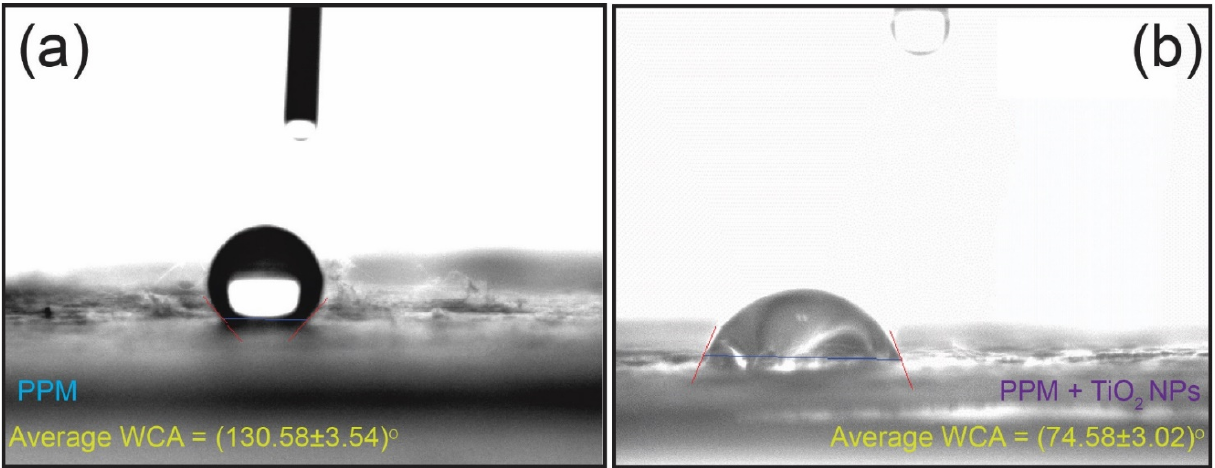
Figure 12. Pictorial representation for the water contact angle of the ( a ) PPM and ( b ) PPM + TiO 2 NPs. Table 2. Water contact angle of the PPM and PPM + TiO 2 NPs in different runs. Serial No.